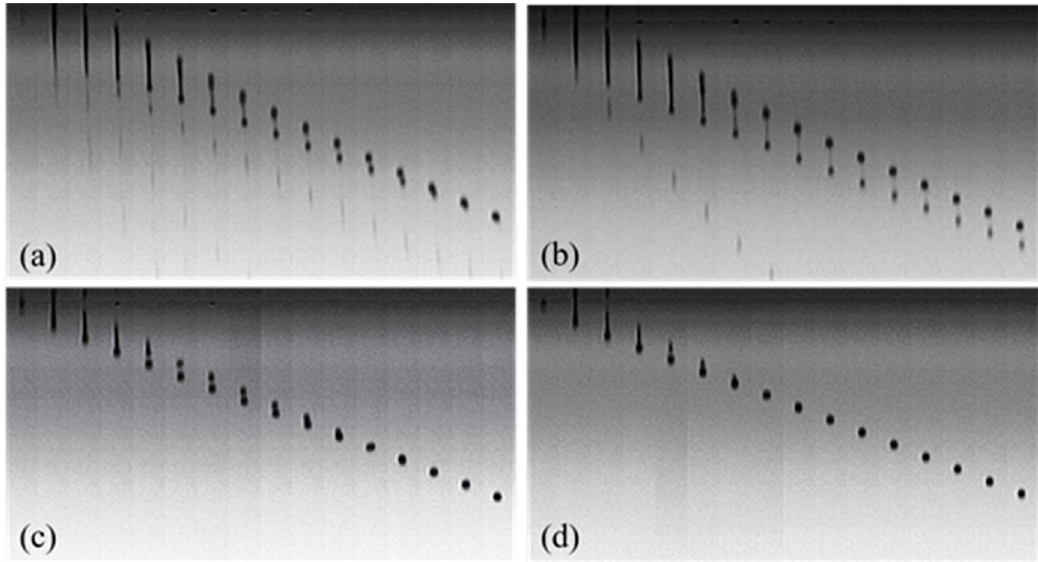
Figure 7. Droplet formation of 7% ( w / w ) Red 218 dye aqueous solutions at different jetting frequency at 25 °C. ( a ) 1500 Hz; ( b ) 5000 Hz; ( c ) 10,000 Hz; ( d ) 20,000 Hz.